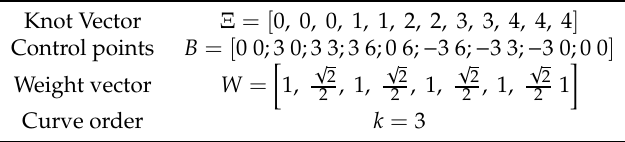
Table 2. Data to create NURBS curve from the plane strain problem.